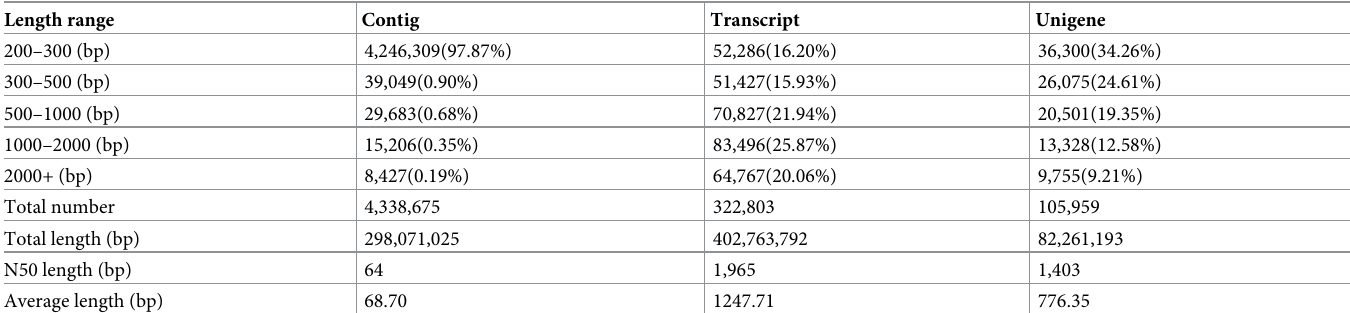
Table 1. Statistics of splicing results of transcriptome sequencing